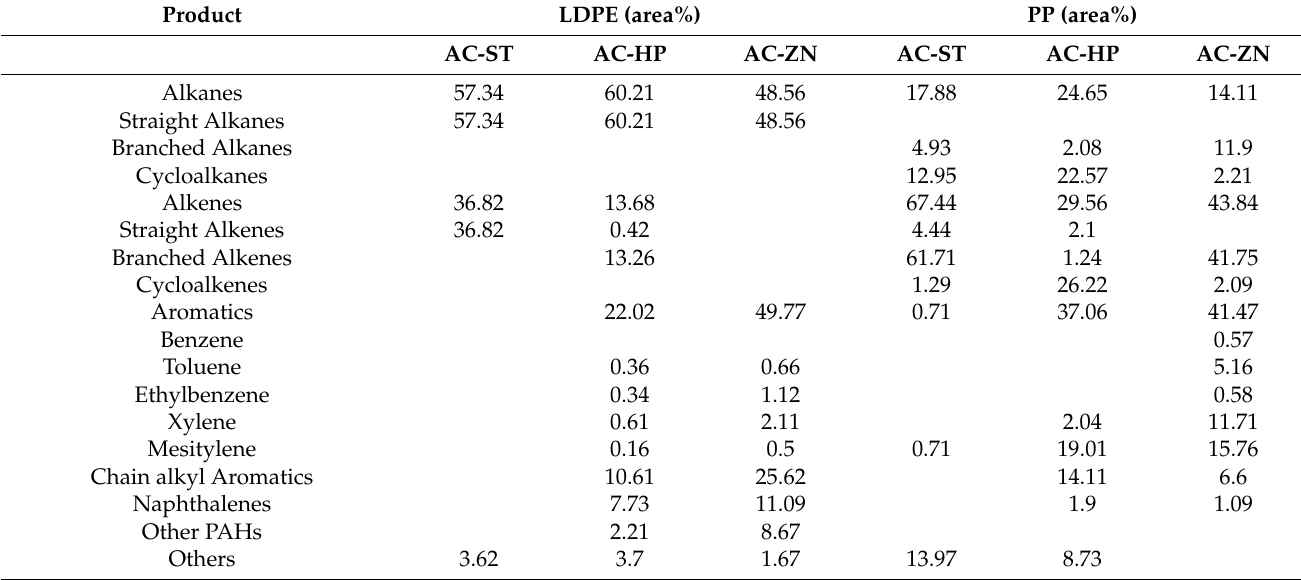
Table 3. The composition of liquid obtained by the cracking of LDPE and